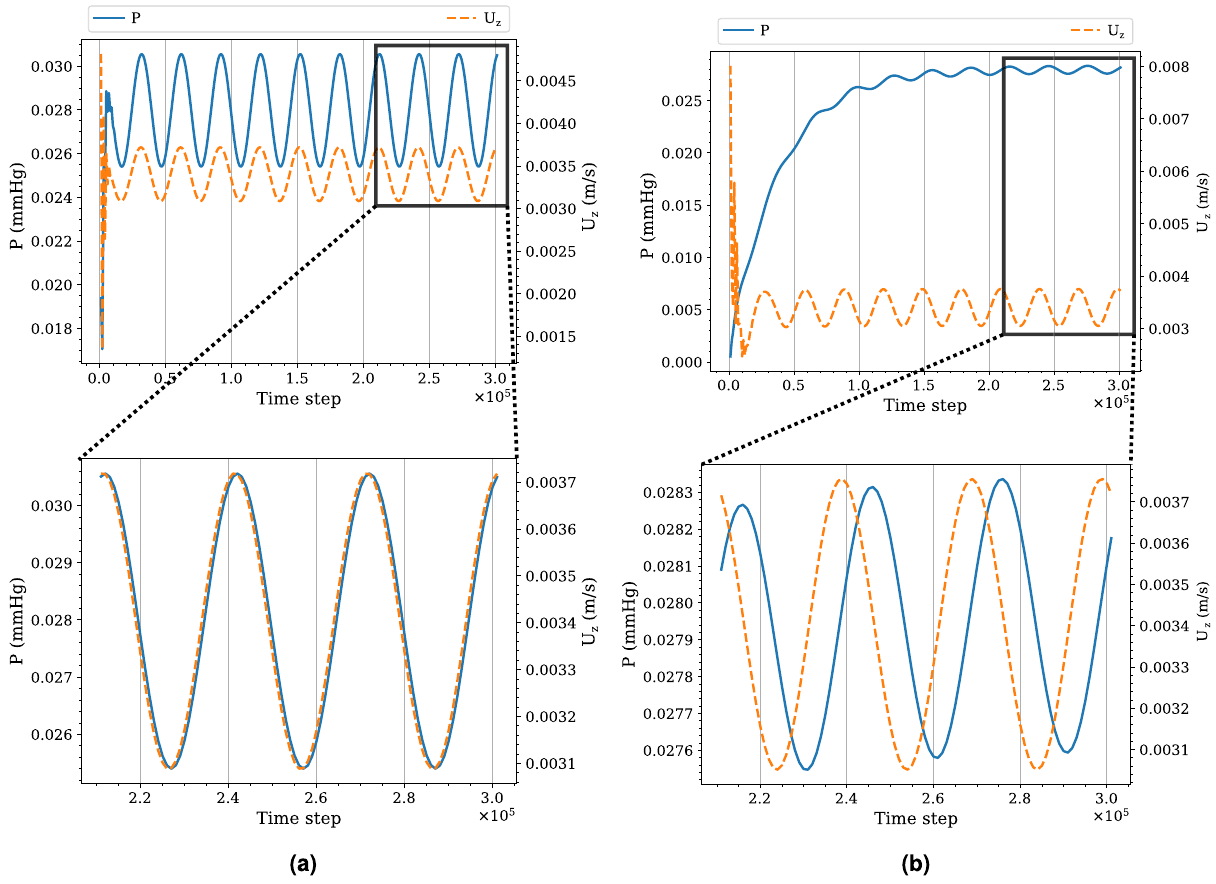
Figure 6. Time series of the pressure ( P ) and the z -component of the flow velocity ( U z ) at the centre of outlet 1 in simulations with different γ RC but the same γ R . The results are obtained from the simulations on the fine grid 0.125 and (b) γ RC 8 with the same γ R 4 . We observe that both P of the five-outlets domain using (a) γ RC = = = and U z converge faster in (b) than (a) ; the phase lag of U z from P is also larger in (b) than (a) .